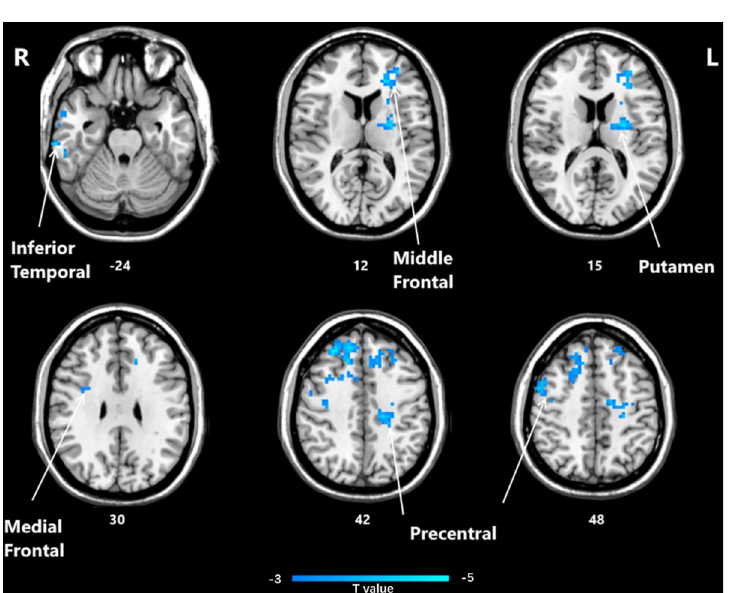
Fig 6. Brain regions that showed significant alterations in ReHo values before and after HD-tDCS. (P < 0.05, AlphaSim corrected). The yellow color denotes post-HD-tDCS > pre-HD-tDCS in the ReHo values and the blue color denotes post-HD-tDCS < pre-HD-tDCS. The T-value bars are shown at the bottom. The brain regions with a significant decrease in ReHo values include Temporal Inf R, Putamen L, Frontal Mid L, Precentral R, Frontal Sup Medial L, Frontal Sup R, and Precentral L. ReHo, regional homogeneity; HD-tDCS, high-definition transcranial direct current stimulation.